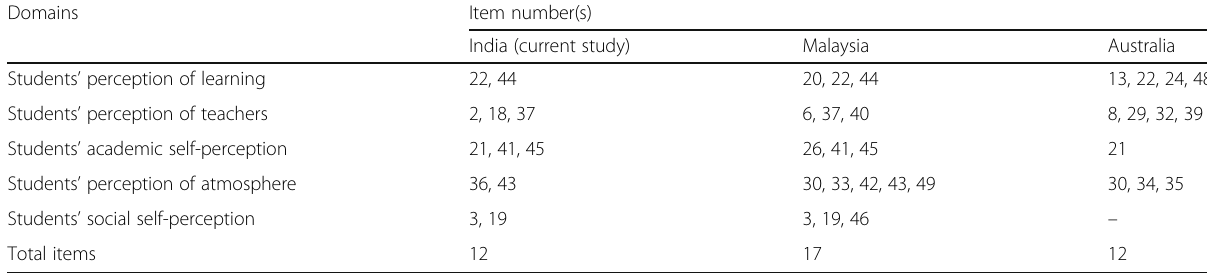
Table 5 Comparison of items in the abridged version of DREEM developed in our study with those in Malaysian and Australian versions Domains Item number(s) India (current study) Students ’ perception of